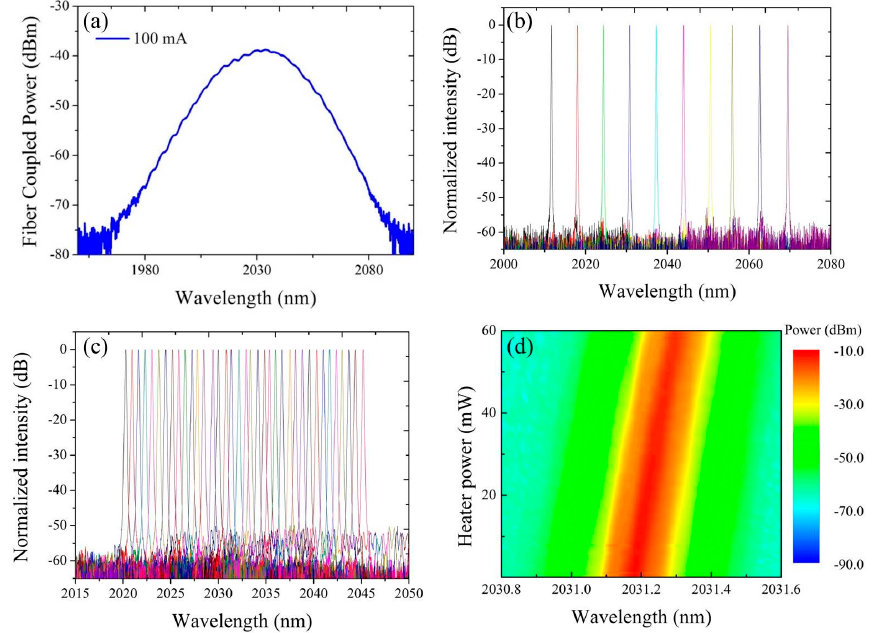
Figure 11. ( a ) Amplified spontaneous emission coupled from the GaSb-based SLD to a silicon waveguide; ( b ) superimposed spectra of the hybrid laser by thermally tuning only one MRR; ( c ) both MRRs and ( d ) phase shifter.